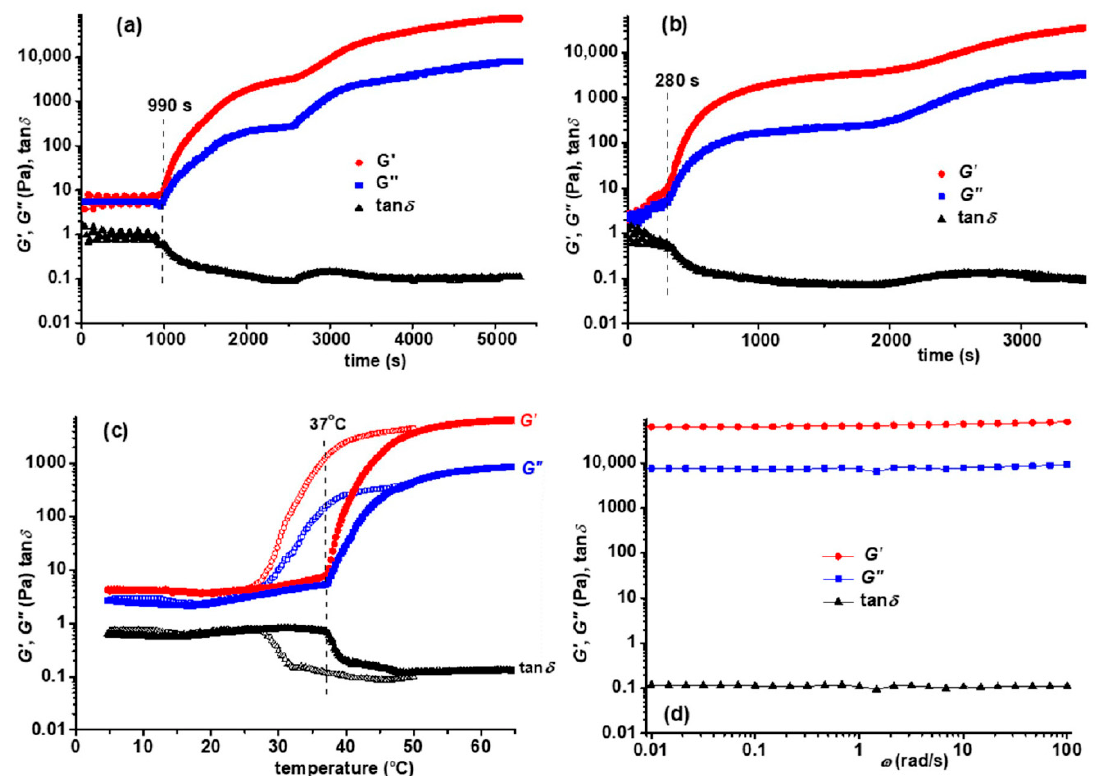
Figure 5. The evolution of the viscoelastic parameters in time for 13% ( w / v ) Plx- g -CMP after 24 h of rest at ( a ) 4 °C; ( b ) 20 °C ( ω = 1 rad/s, γ = 1%), raising the sample temperature at 37 °C inside of the rheometer; as a function of temperature at increasing (full symbols) and decreasing the temperature (empty symbols) after 24 h of rest at 4 °C (heating/cooling rate of 0.5 °C/min, ω = 1 rad/s, γ = 1%) ( c ); as a function of the oscillation frequency after 2 h of rest at 37 °C for the sample previously kept at 4 °C ( γ = 1%) ( d ).